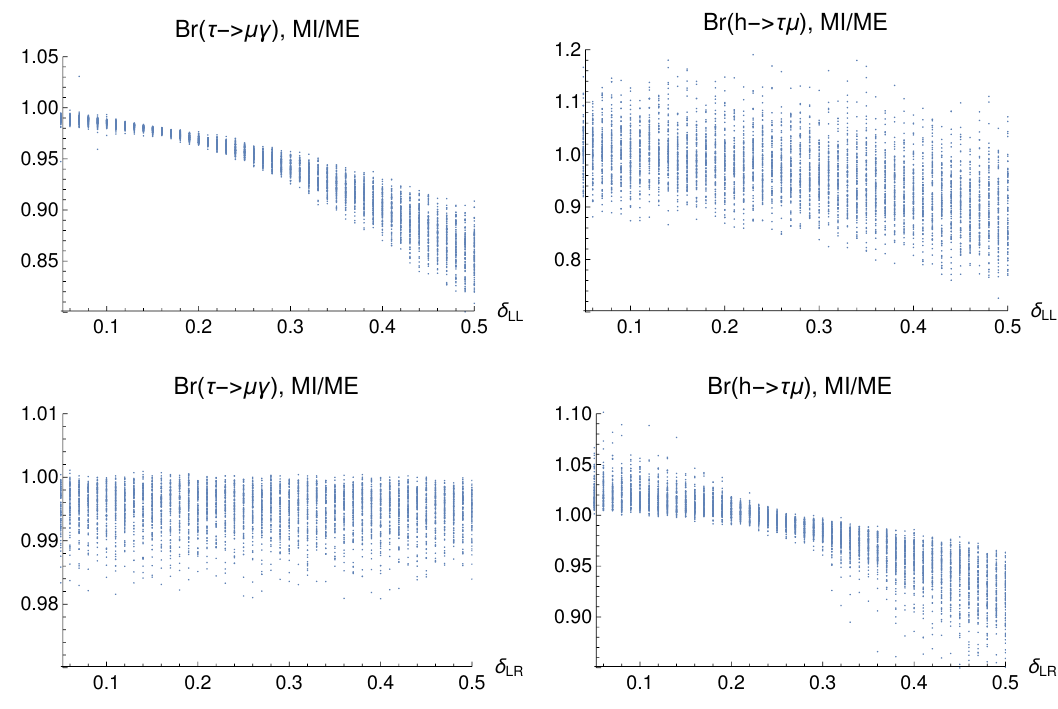
Figure 7 . Accuracy of MI expansion for the (cid:28) ! (cid:22)(cid:13) and h ! (cid:28)(cid:22) decay rates. Points show the ratio Br( (cid:28) ! (cid:22)(cid:13) ) MI = Br( (cid:28) ! (cid:22)(cid:13) ) ME (lower and upper left panel) and Br( h ! (cid:28)(cid:22) ) MI = Br( h ! (cid:28)(cid:22) ) ME (lower and upper right panel) as a function of LL and LR mass insertion for tan (cid:12) = 5 and random choice of other model parameters (see eq.